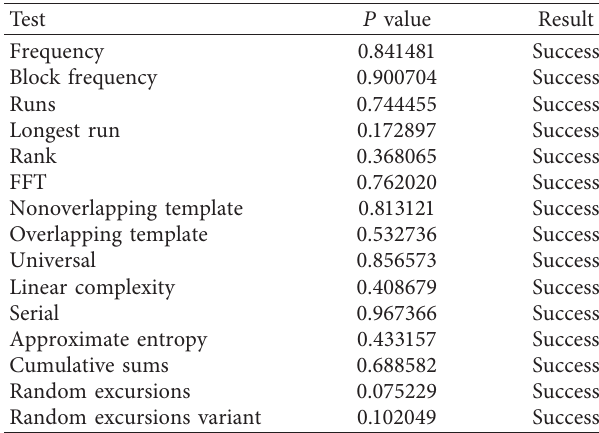
Table 4: Pseudorandom properties of torus-chaotic system with decorrelation